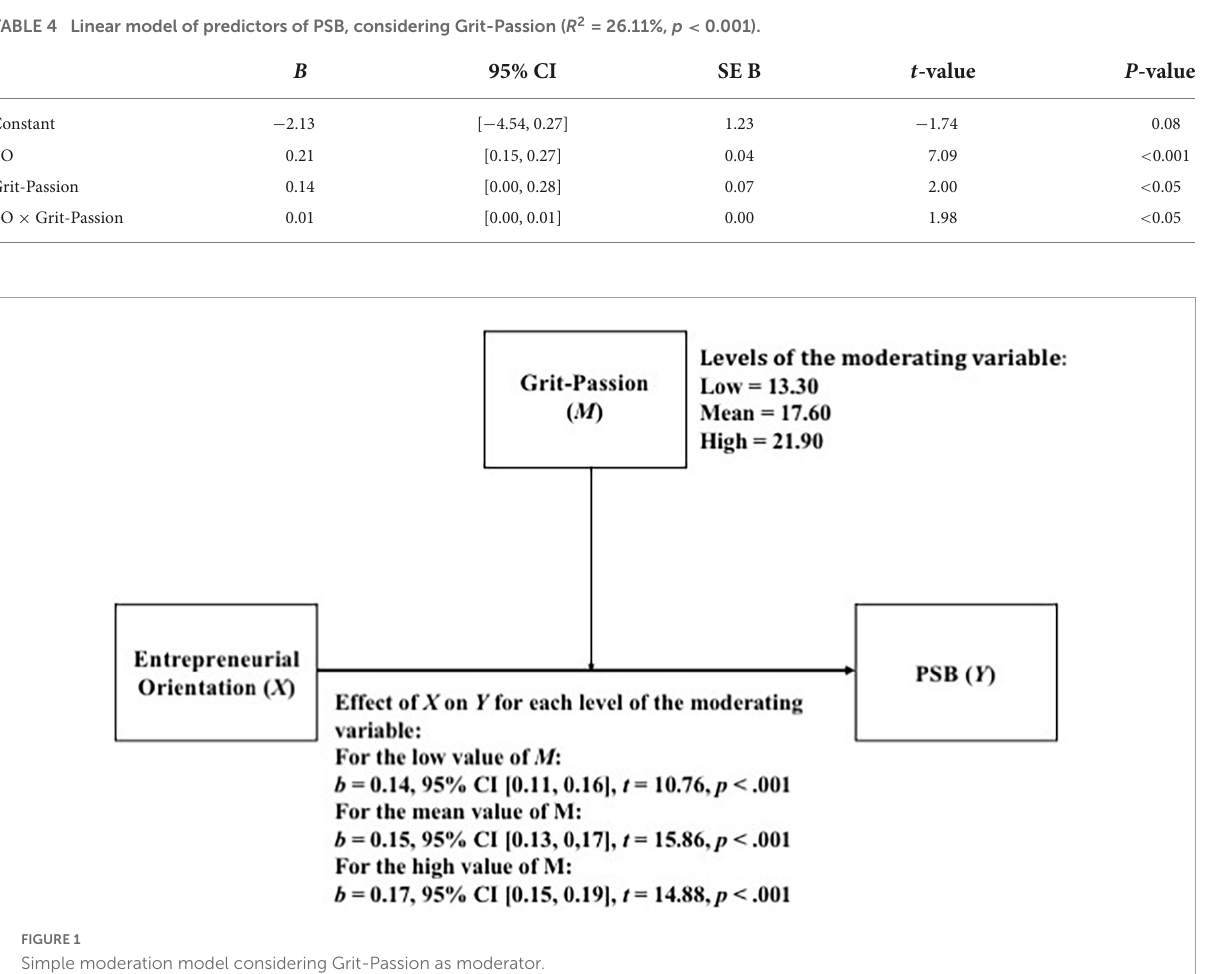
of all the models used. Due to the quantity and complexity of the models, only the results of the triple interaction between the EO, the Grit-Passion, and each of the sociodemographic factors are presented, as this is the only factor that can show if the double moderation is statistically significant. These results are presented in Table 5